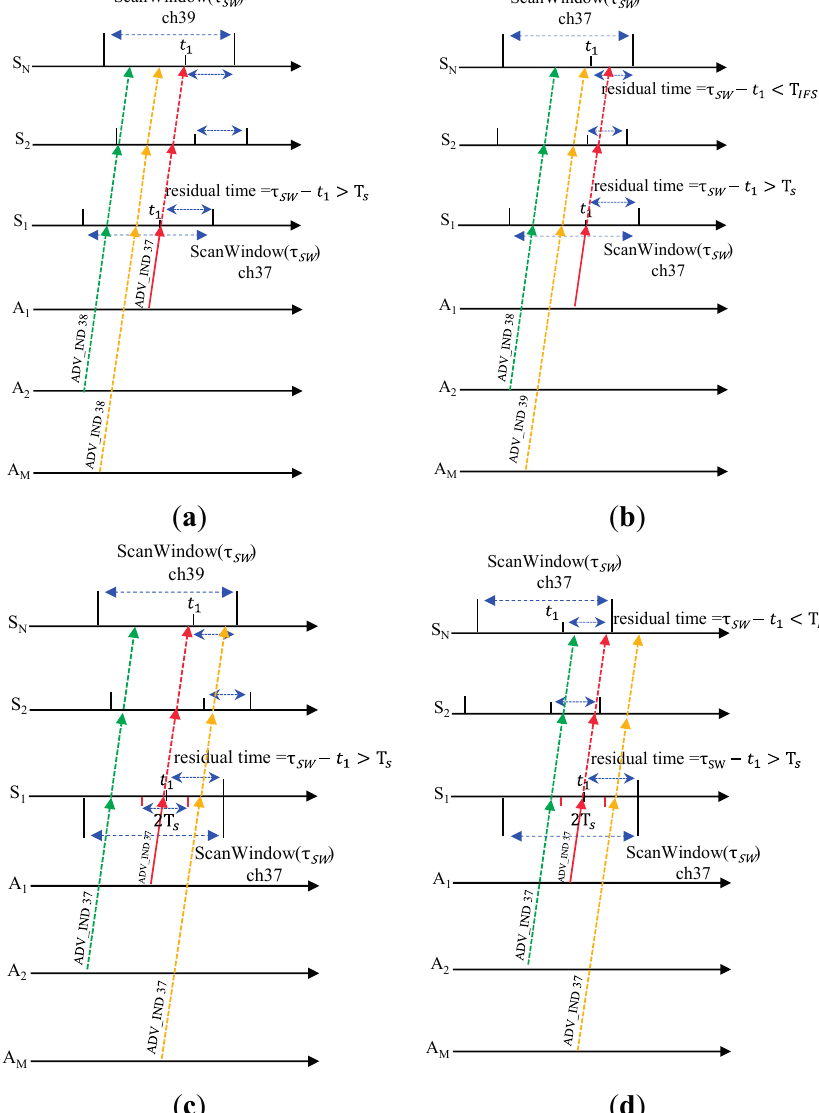
Figure 6. Cases for successful discovery in M:N network. ( a ) Case 4 (E1 ∩ E2 ∩ E3